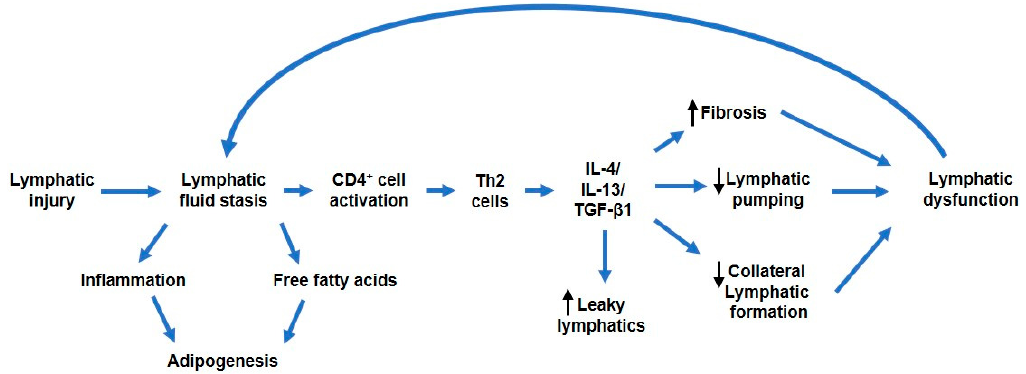
Figure 2. Schematic showing proposed pathophysiologic consequences following initial lymphatic injury. The accumulation of lymphatic fluid incites adipogenesis and an inflammatory response that sets o ff a cascade of molecular events leading to lymphatic impairment. Notably, of the inflammatory response, CD4 + T cell activation has been shown to be both necessary and sufi ffi cent for the development of lymphedema. CD4 + T cell activation induces elaboration of T helper 2 (Th2) cytokines IL-4 and IL-13, along with transforming growth factor- β 1 (TGF- β 1), that contribute to lymphatic dysfunction either directly or indirectly by promoting tissue fibrosis, decreasing lymphatic pumping, impairing collateral lymphatic formation, and increasing lymphatic leakiness. The culminative e ff ect is worsening of lymphatic fluid